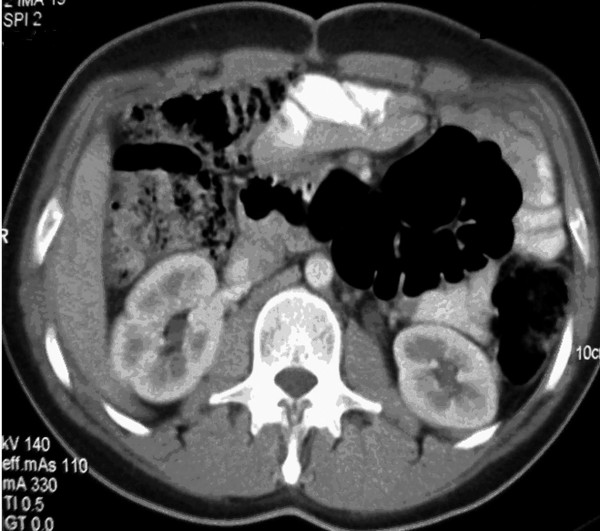
CT scan. No evidence of tumor activity is demonstrated. Localization of intraabdominal organs is adequate.